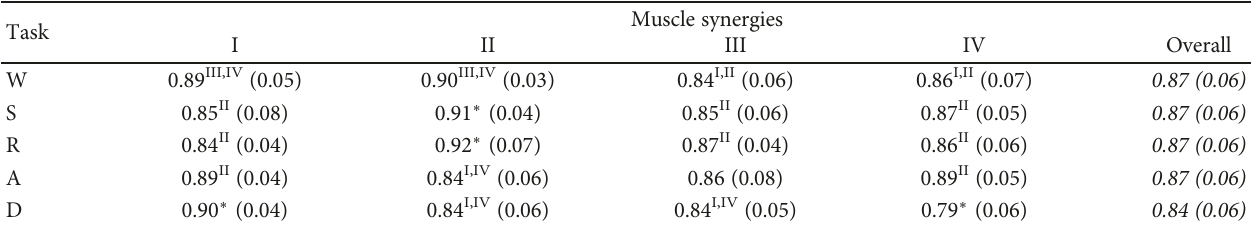
Table 11: Mean value and standard deviations (SDs) related to the B R 2 evaluated synergy by synergy for each task. Di ff erences between pair of synergies in each task are reported in superscript with the relative roman number; ∗ stands for statistical di ff erences among all synergies. The overall means evaluated considering all the synergies together are reported in